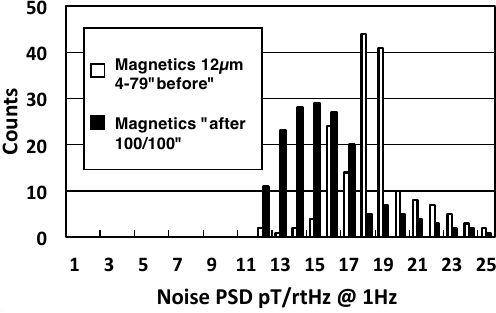
Figure 1. Histograms of noise power for 4–79 permalloy ring